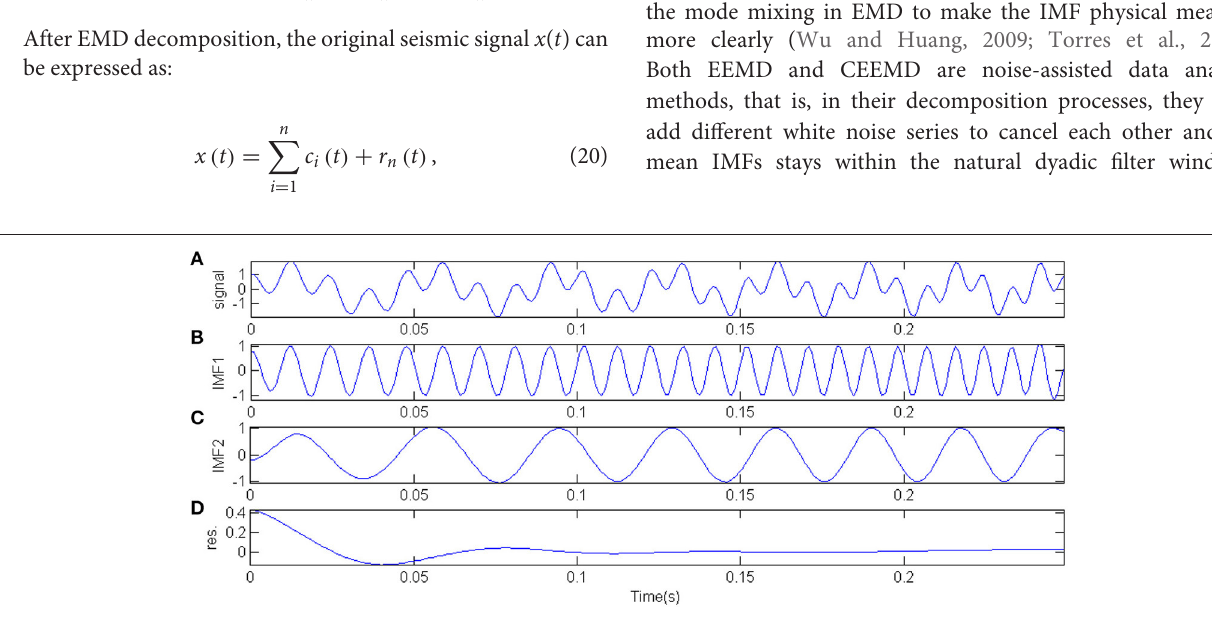
Frontiers in Earth Science |